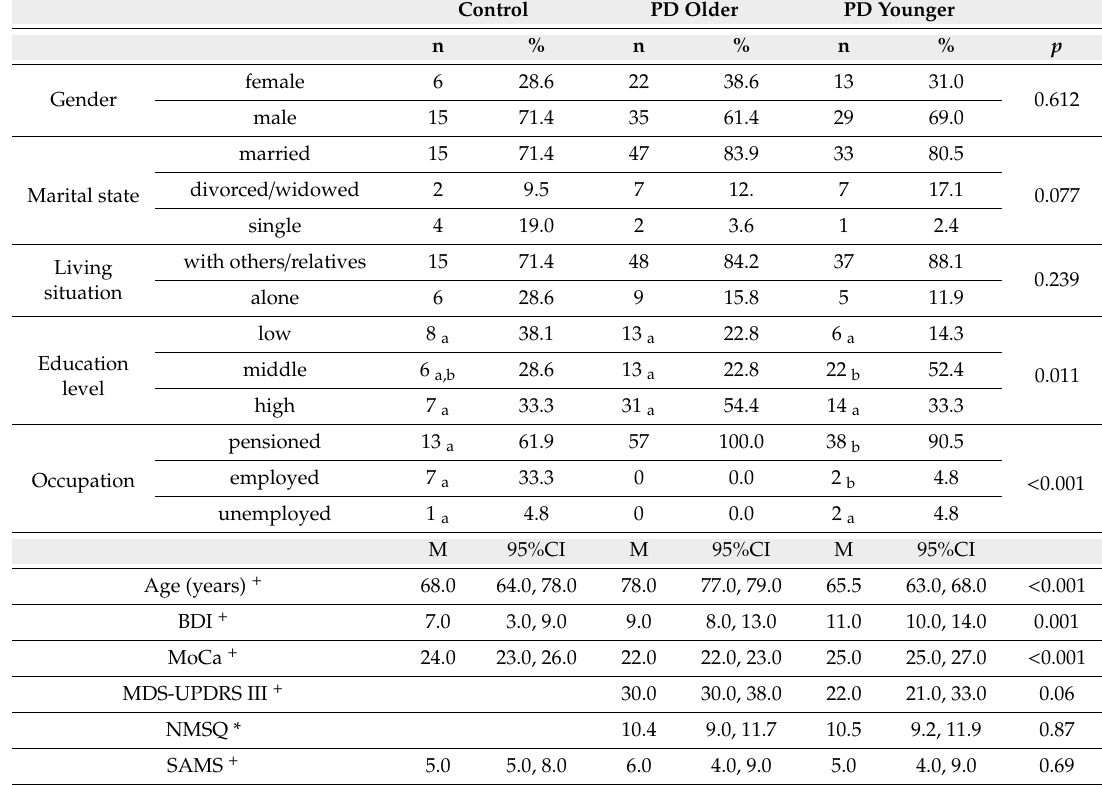
Table 1. Clinical and demographic